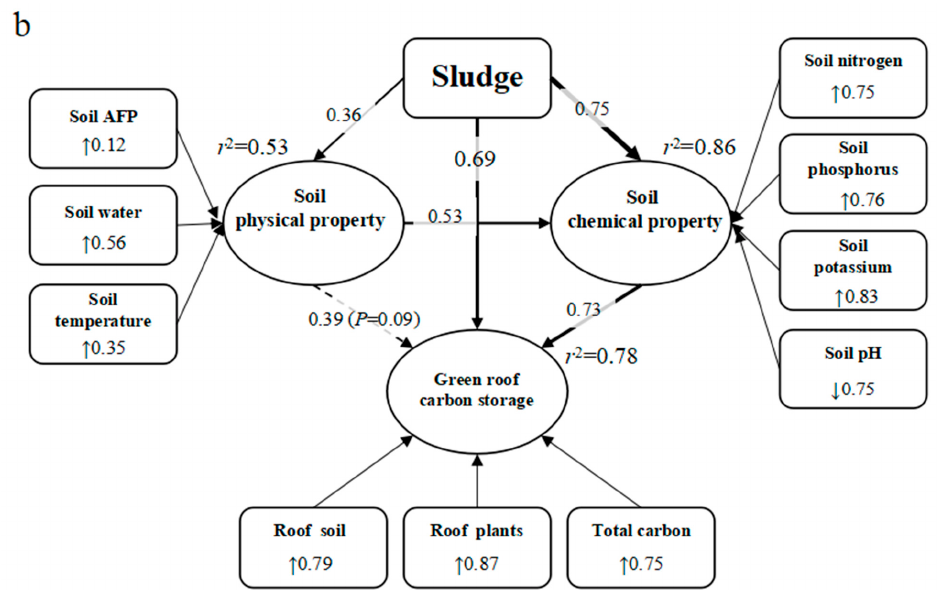
Figure 5. Structural equation model (SEM) analysis of the effects of additives on green roofs’ carbon storage potential. ( a ) The mechanism of biochar influence on green roof carbon storage potential. ( b ) The mechanism of the sludge influence on green roof carbon storage potential. The square boxes indicate variables included in the model: Soil APF = soil air-filled porosity. The symbols “ ↑ ” and “ ↓ ” indicate a significant increase or decrease, respectively, in response to the inclusion of the additives. The number in each square box indicates the response to additives’ addition. Results of model fitting: ( a ) χ 2 = 182.382, p = 0.061, df = 28, AGFI = 0.902. ( b ) χ 2 = 137.692, p = 0.076, df = 28, AGFI = 0.907 (a high P value associated with a χ 2 test indicates a good fit of the model to the data, i.e., no significant discrepancies, AGFI = adjusted goodness-of-fit index > 0.9 indicates that the model has a high degree of adaptation). The solid and dashed arrows indicate significant ( p < 0.05) and non-significant effects ( p > 0.05), respectively; the r 2 values associated with the response variables indicate the proportion of variation explained by the relationships with other variables. The values associated with the solid arrows represent standardized path coefficients.